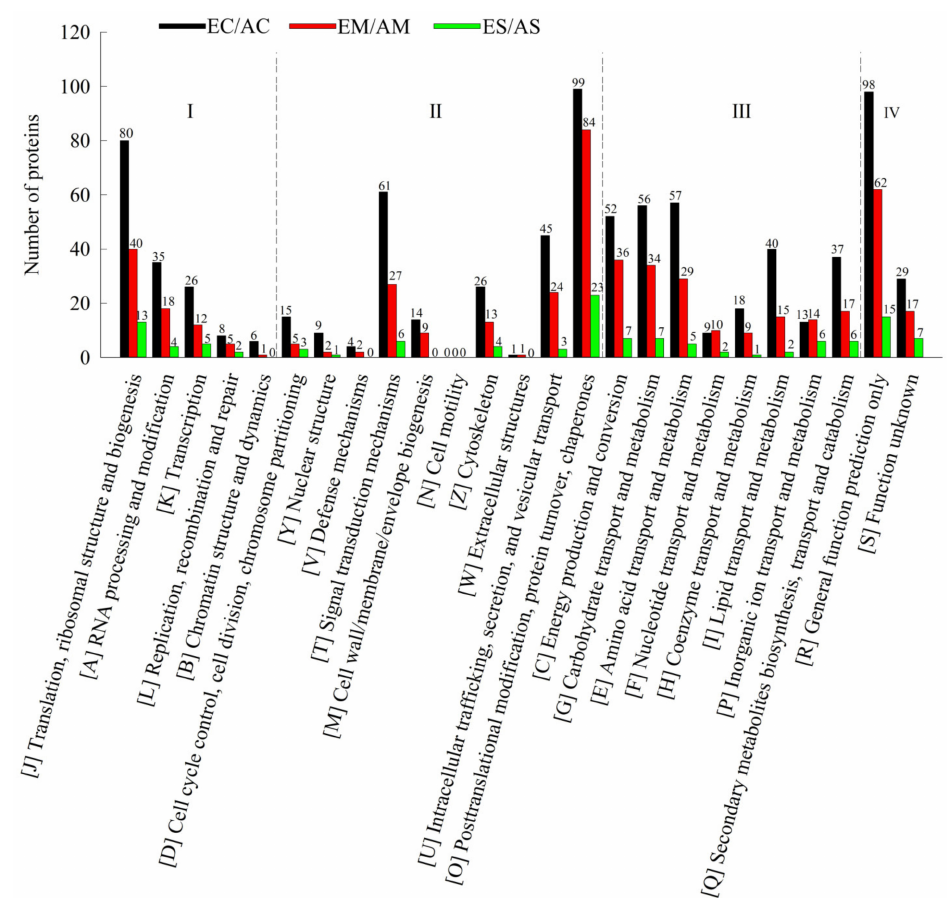
Figure 2. KOG functional classification chart of differential proteins under [CO 2 ] enrichment: (I) in- formation storage and processing, (II) cellular processes and signals, (III) metabolism, and (IV) other unknown